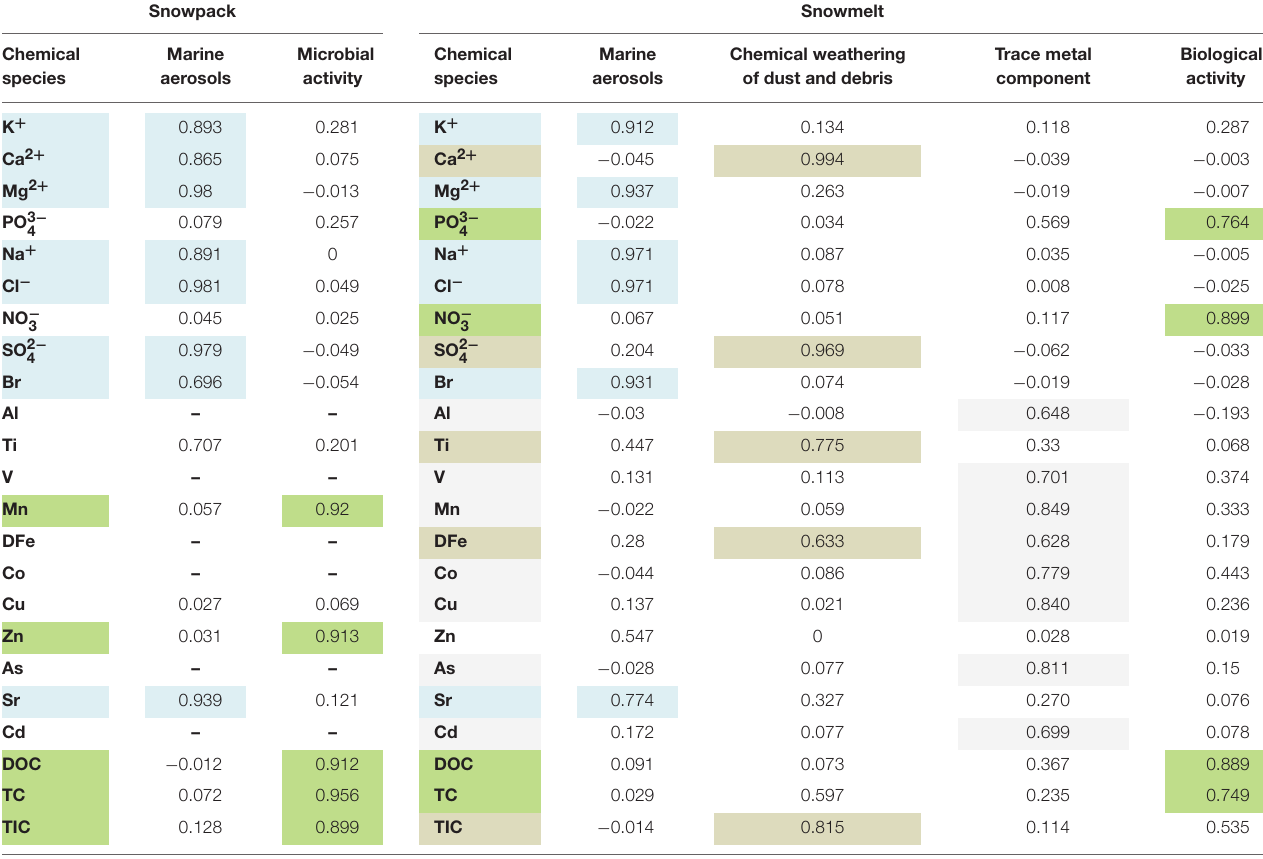
TABLE 3 | Results of the principal component analyses performed on the snowpack and snowmelt samples. Snowpack Snowmelt Chemical Marine Microbial Chemical Marine Chemical weathering species aerosols activity species aerosols of dust and debris